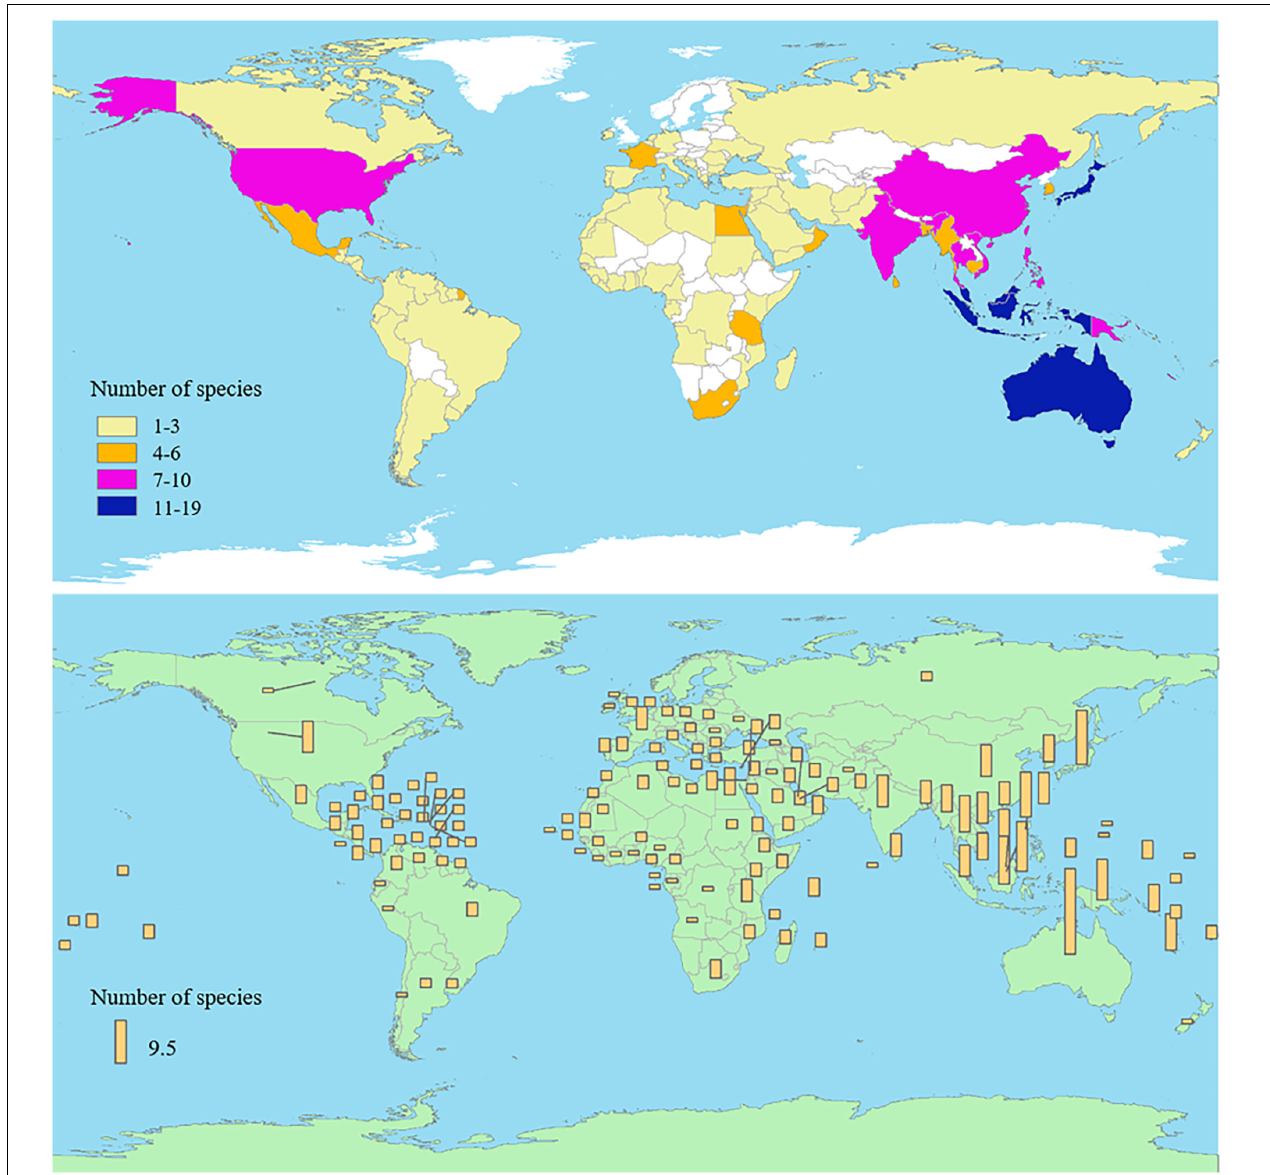
FIGURE 1 | The number of Hippocampus species in different countries and